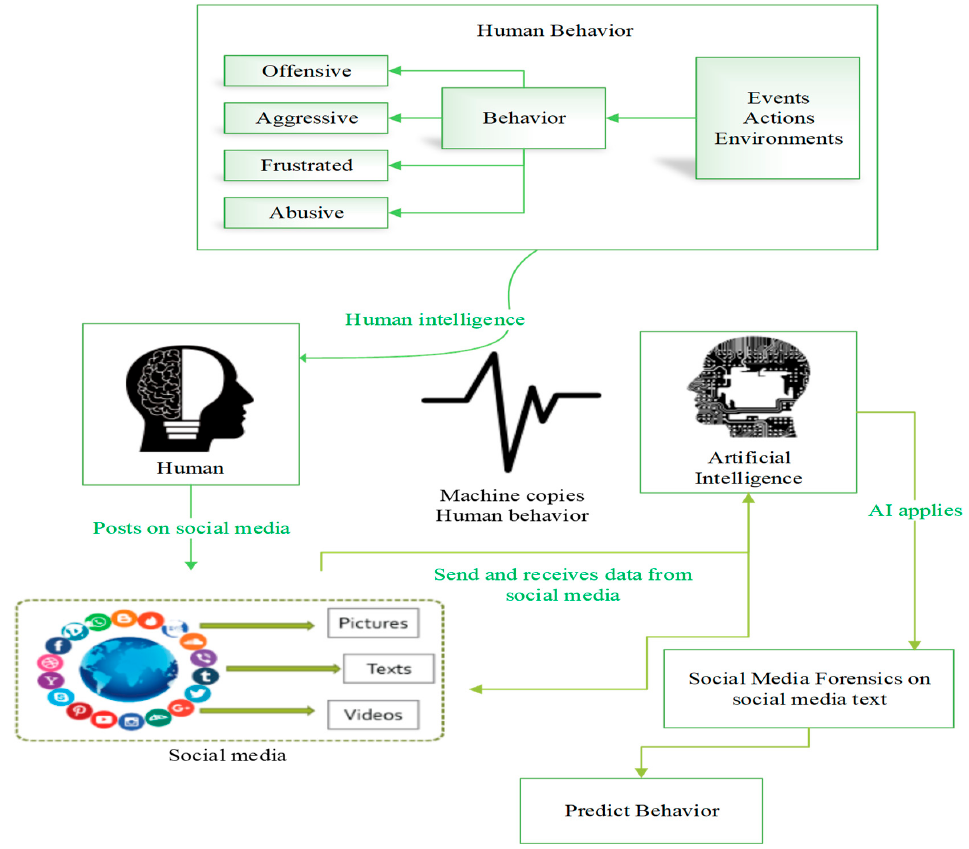
Figure 2. Human vs. Artificial Intelligence.